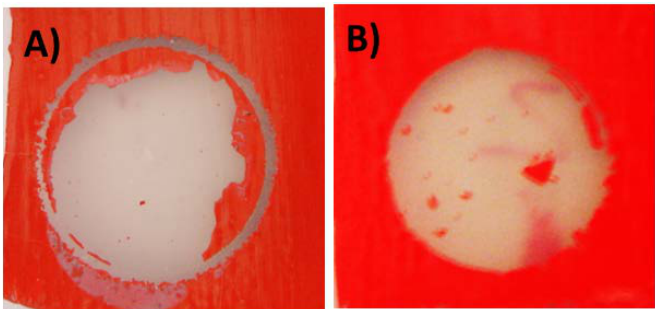
Figure 11. Adhesion pull-off test of treated PDMS coated with PU ( A ) and EP ( B ).